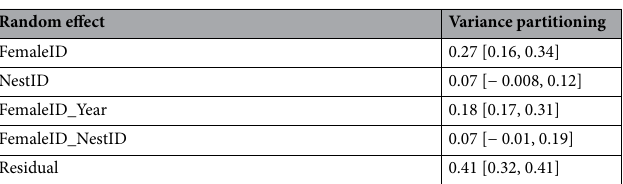
Table 4. The relative contribution of random effects to the total variance. 95% confidence intervals are calculated with parametric bootstrapping and are shown between brackets.